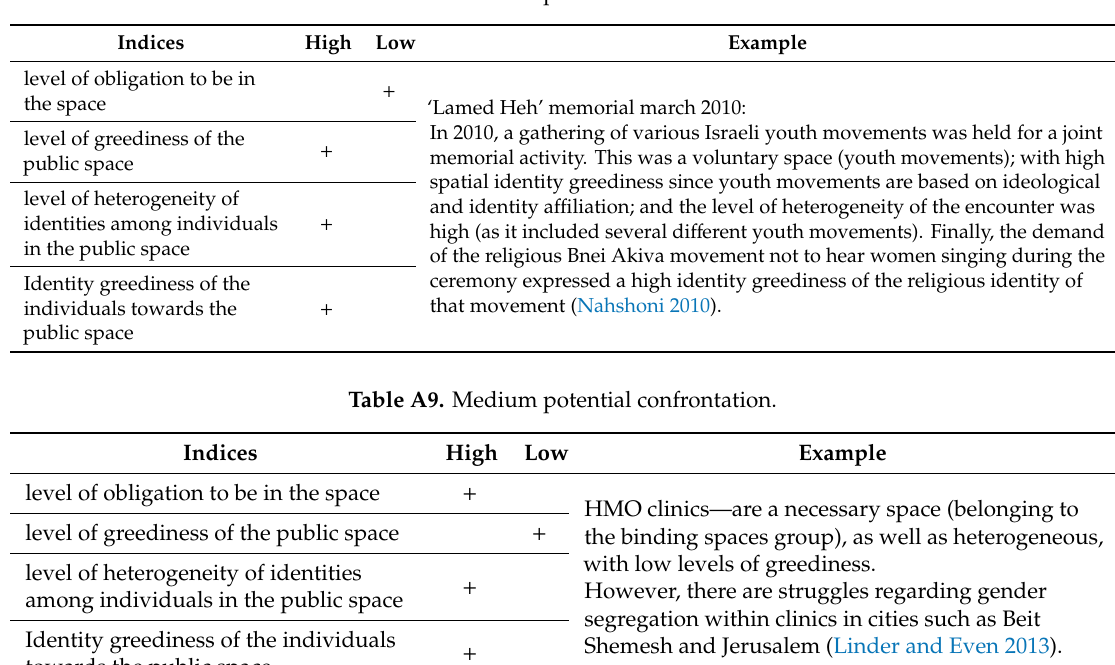
Table A8. Medium potential confrontation.